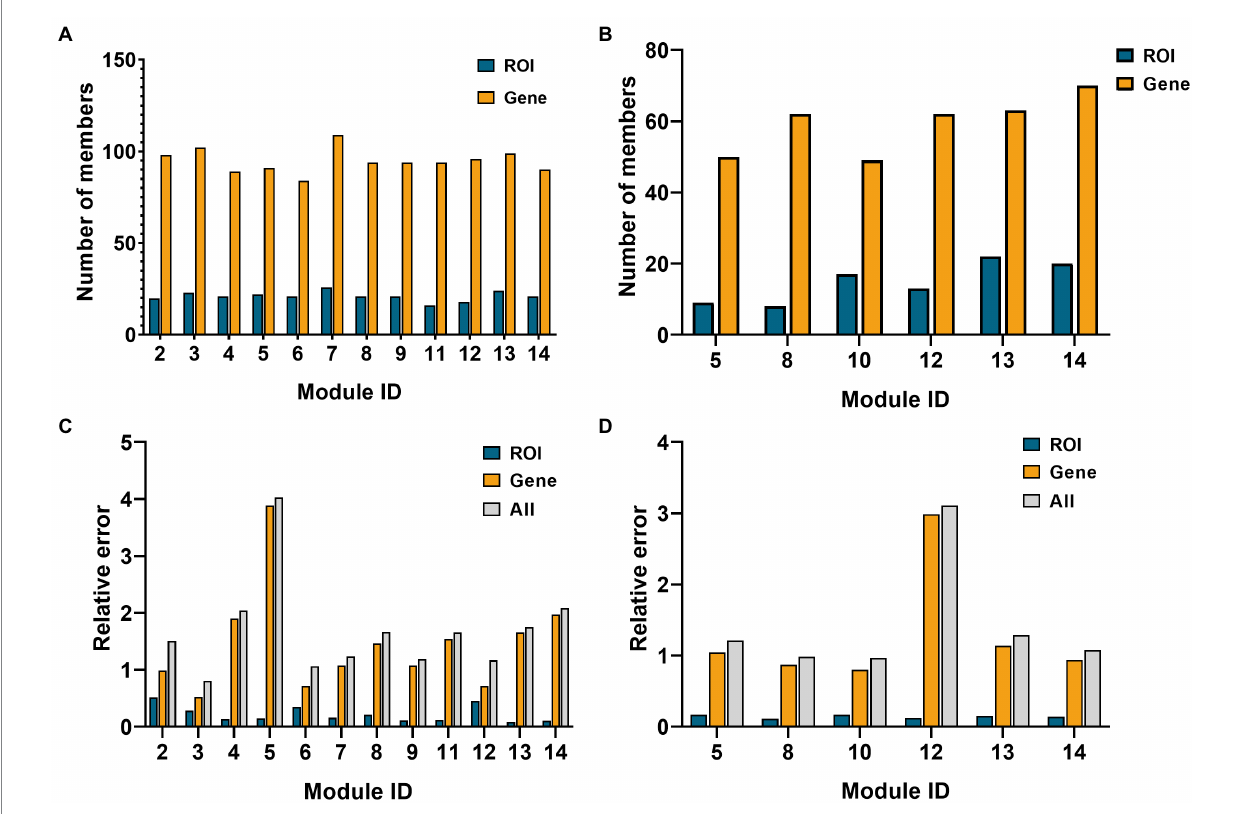
FIGURE 4 Histogram of network module selection in the AD group and MCI group. (A,B) Are the element numbers of ROIs and genes in the retained modules in the AD and MCI groups, respectively. (C,D) Are the ROIs, genes, and relative errors of the two in the retained modules in AD and MCI groups,